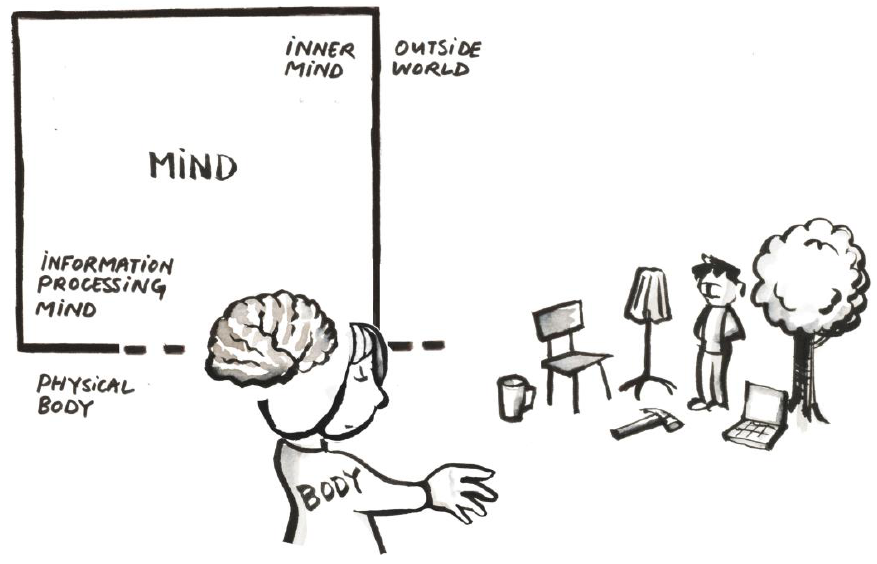
Figure 2. The dualistic character of cognitivism results in splits between on the one hand the ‘information processing mind’ and the ‘physical body’ (horizontal split) and on the other hand the ‘inner mind’ and the ‘outside world’ (vertical split). © Jelle van Dijk.